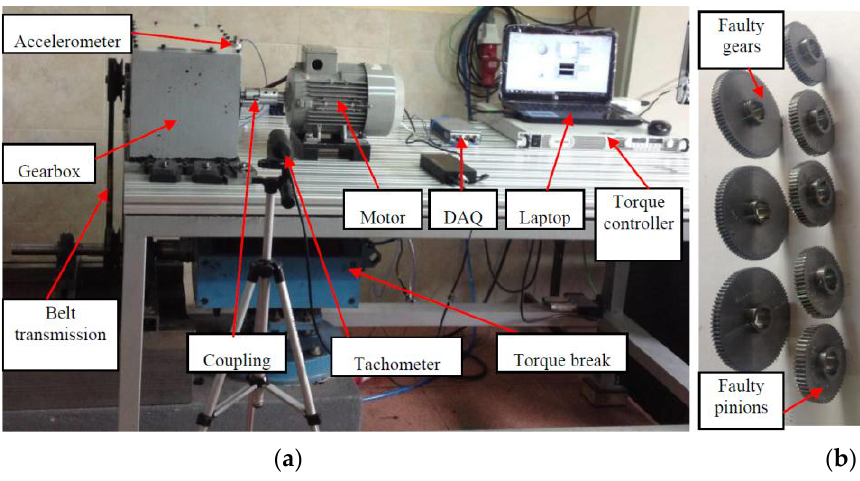
Figure 4. Gearbox fault diagnosis configurations: ( a ) experimental set-up; and ( b ) three different faulty gears and five different faulty pinions.